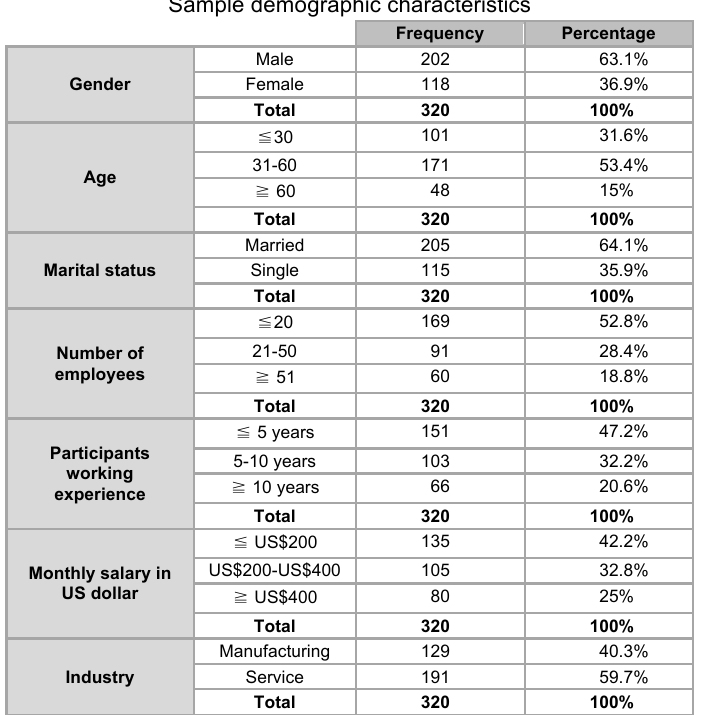
Sample demographic